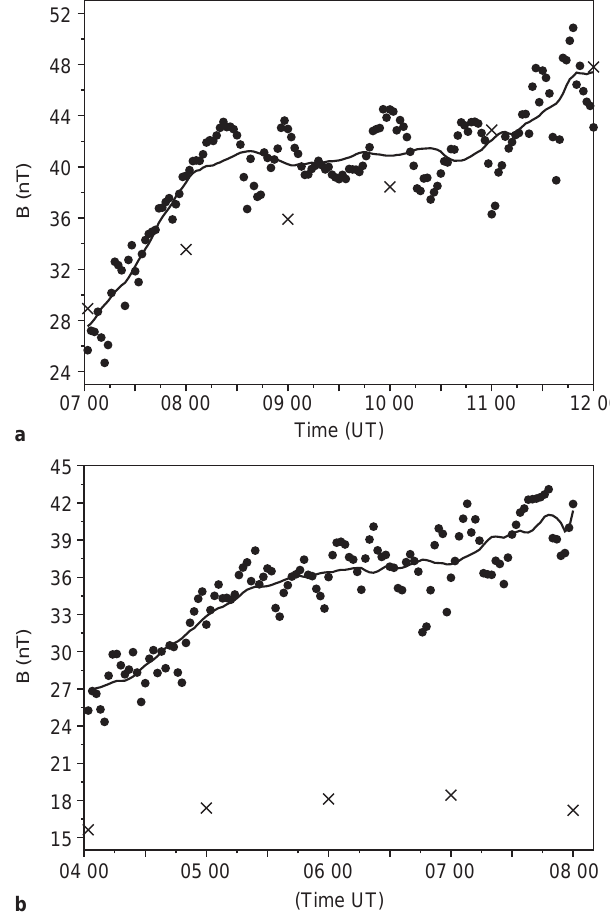
Fig. 5a, b. Averaged values of the magnetic field magnitude ( solid lines ) and corresponding experimental data with 2 min resolution ( points ) are presented for time intervals from 07:00 UT to 12:00 UT 2 October, 1995 and of from 04:00 UT to 8:00 UT 25